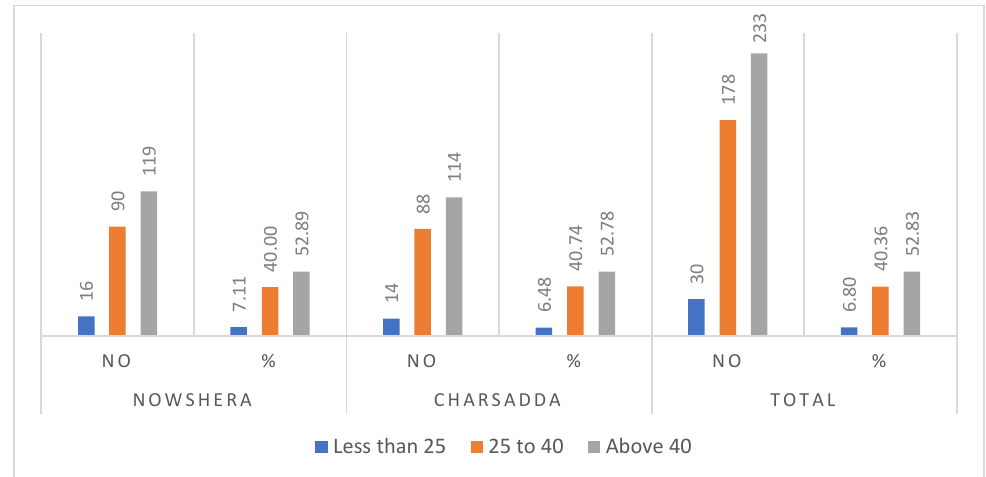
Figure 5. Flood risk perception varies based on the household head ’s education.